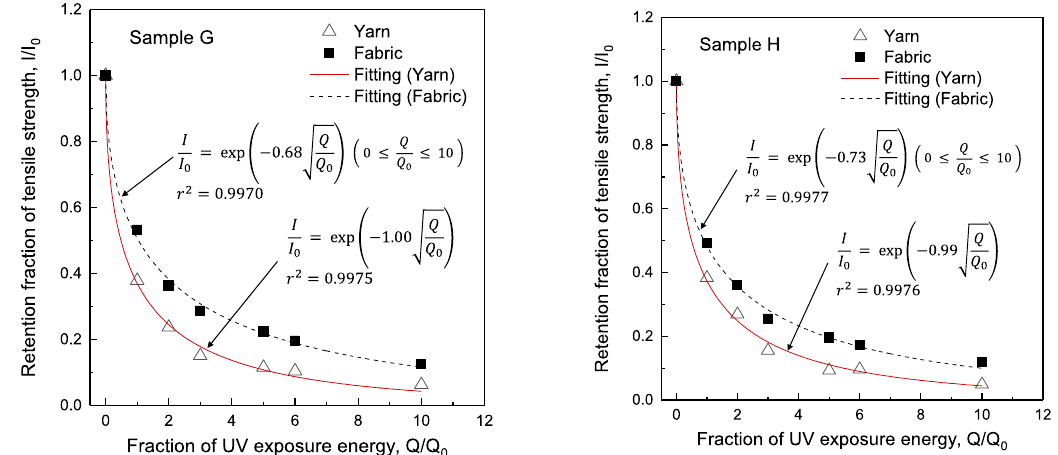
Figure 6. Relationship between the fraction of UV exposure energy and retention fraction of tensile strength of yarns and fabrics on Samples A to H. White- and black-filled symbols represent experi- mental data of yarn and fabric, respectively. The solid and dotted lines represent the fitting data of the yarn and fabric by Equation (3).